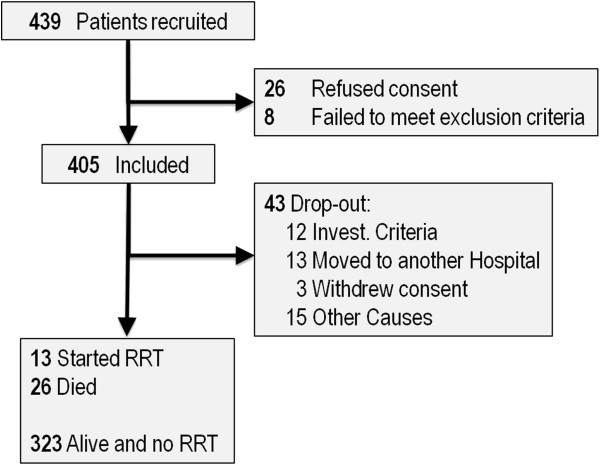
Flowchart of subjects included in the study.